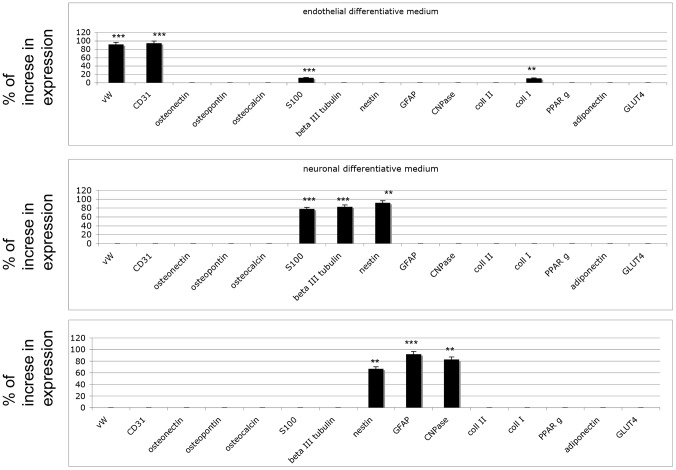
Gene expression by real-time PCR on DPSCs in endothelial, neuronal or glial differentiation medium.One-way analysis of variance was used for data analyses. T tests were used to determine significant differences (p<0.05). * p<0,05; * * p<0,01; * * * p<0,001. Repeatability was calculated as the standard deviation of the difference between measurements.